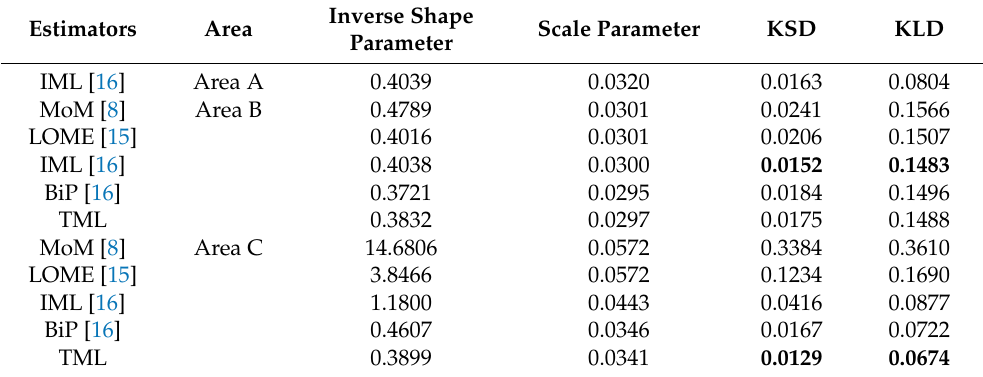
Table 2. Experimental results of the five estimation methods on one dataset from the CSIR database.